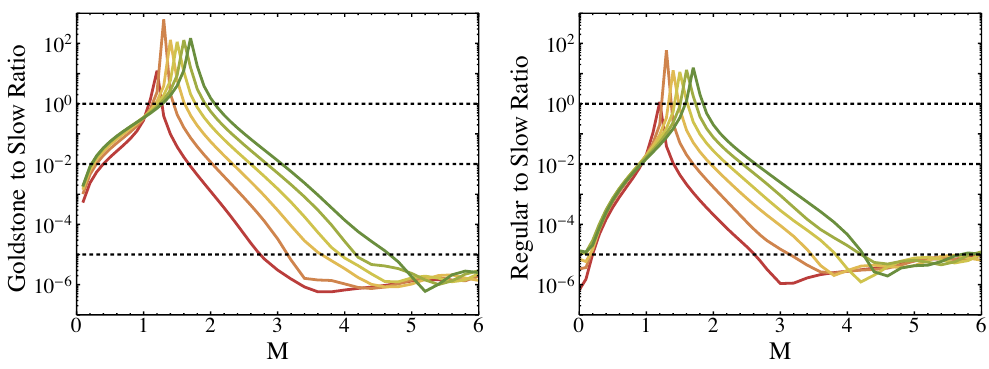
Figure 14 . The ratio of the (cid:12)nal scalar power spectrum computed using the Higgs and Slow initial conditions (left) and using the Regular and Slow initial conditions (right). The color-coding follows (cid:12)gure 9. The black-dotted lines correspond to ratio of 1, 10 (cid:0) 2 and 10 (cid:0) 5